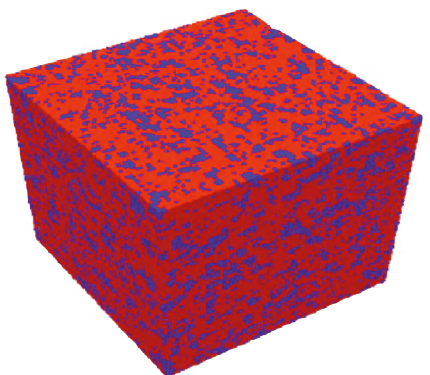
Figure 6: Reconstruction of 3D digital cores by the SA method. The blue part is the pore; the red part is the skeleton. It can be seen that the constructed 3D digital core has better pore connectivity and is similar to the real pore space. Figure reprinted from